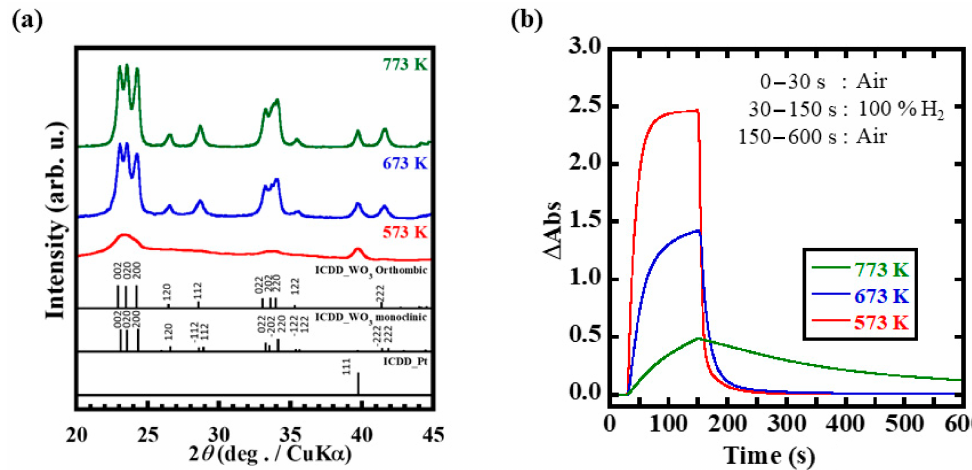
Figure 5. Dependence of H 2 response on the Pt/WO 3 nanoparticle heat treatment temperature. ( a ) Pt/WO 3 powder XRD spectra. ( b ) H 2 response measured at 800